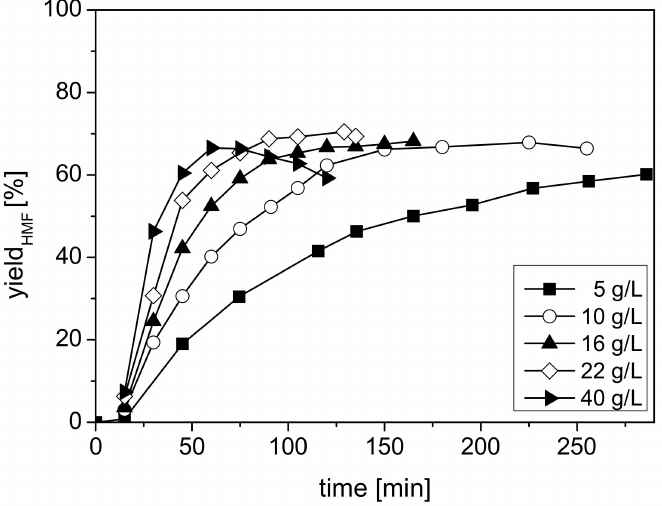
Figure 3. Effect of catalyst concentration on the HMF yield. Reaction conditions: 0.5 M fructose, 15 vol % water in HFIP, 5–40 g/L (5.4–43 mol %) Lewatit K2420 and 110 ◦